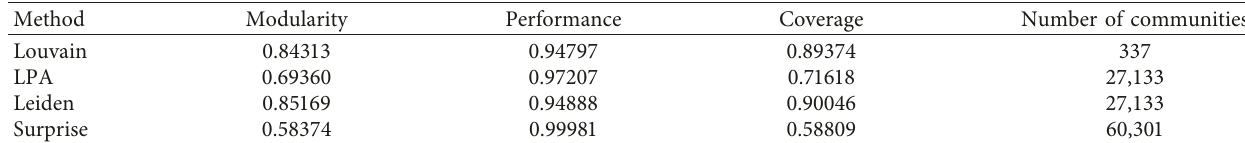
Table 20: For retweeting interactions network from March 8 until May 26 in 2021, useful metrics for evaluation of the community detection algorithms, and number of communities identified in